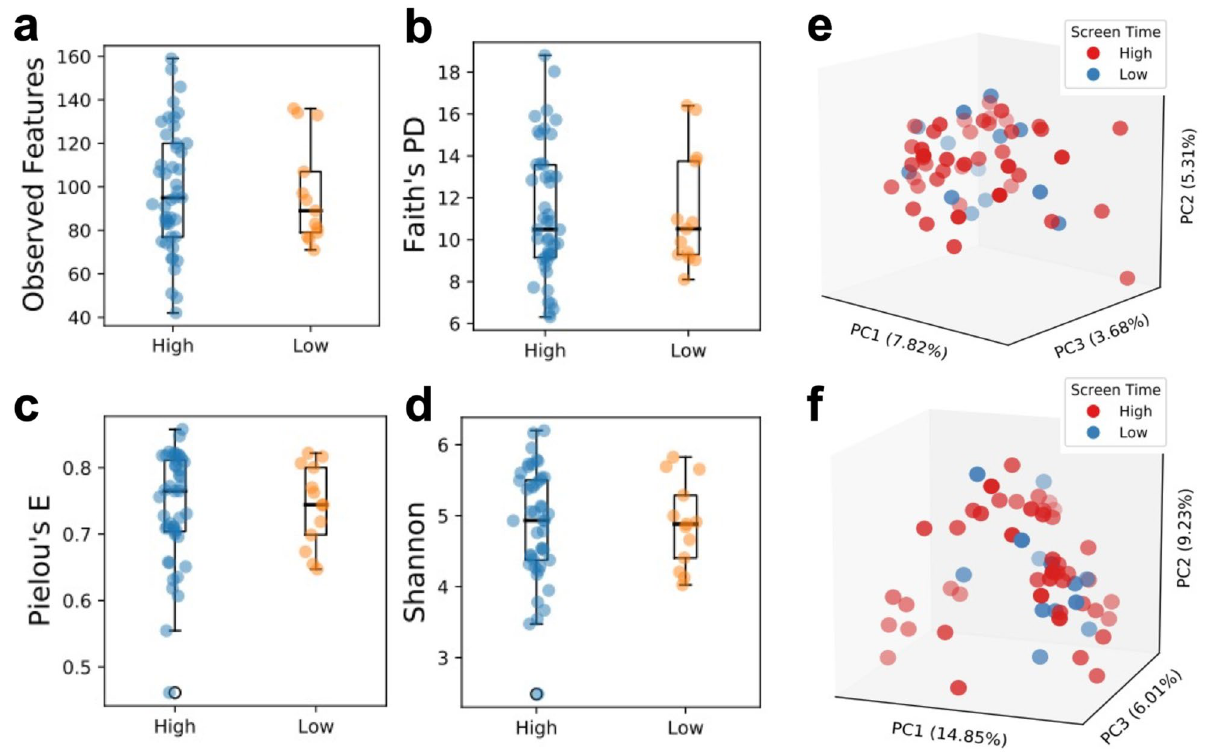
Figure 2. Comparison of alpha and beta diversity metrics between high and low screen time classifications. Boxplots for alpha diversity metrics: ( a ) observed features (unweighted amplicon sequence variants). ( b ) Faith’s PD (phylogenetic diversity). ( c ) Pielou’s E (species evenness). ( d ) Shannon index (weighted proportional abundances). PCoA plots for beta diversity metrics: ( e ) Jaccard. ( f ) Bray–Curtis. Weighted and unweighted UniFrac distance matrices not